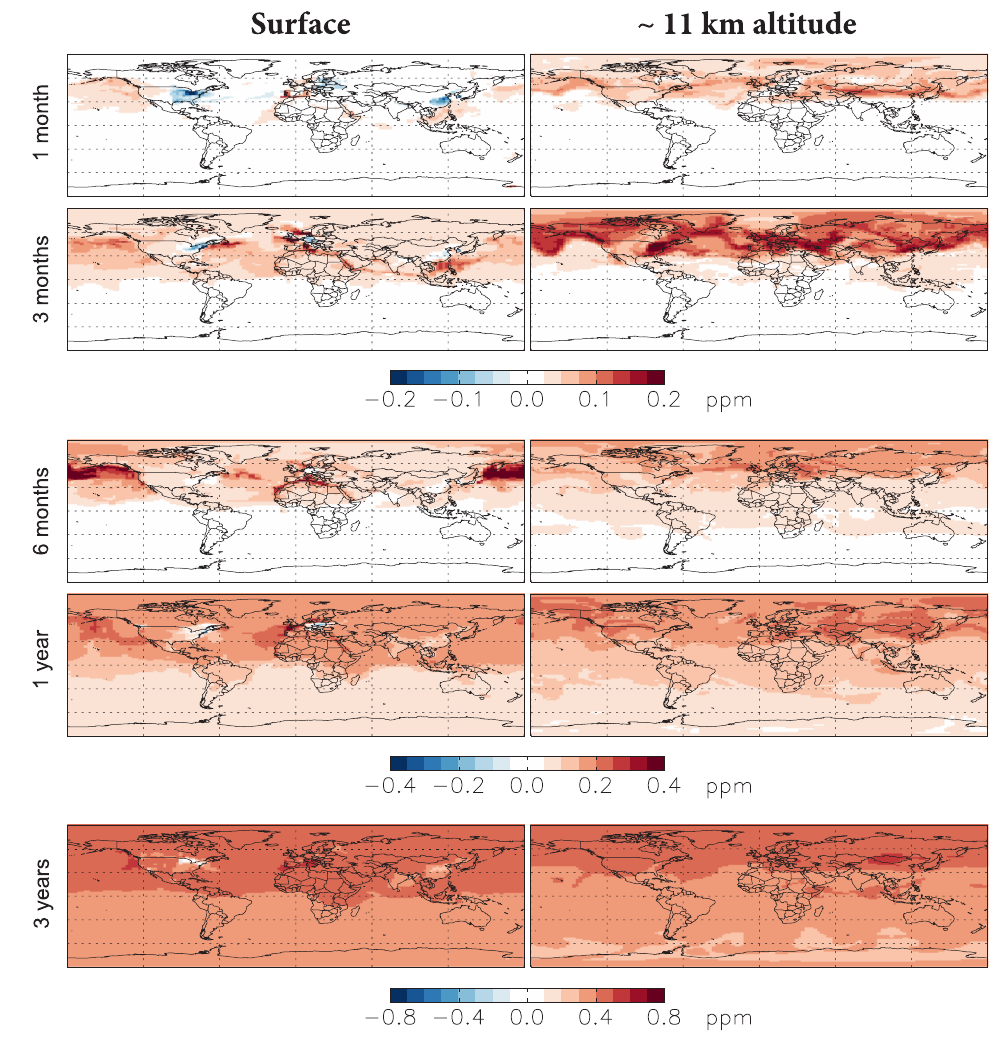
Fig. 4. Combined impact of shipping and aviation emissions on CO 2 at increments up to 3years at the surface and at the model level near 11km altitude where aviation emissions peak. The small negative CO 2 changes at the surface (which are most visible in the first month in the US and China) are a result of the correction to the land fossil fuel source to avoid counting emissions from domestic aviation in both